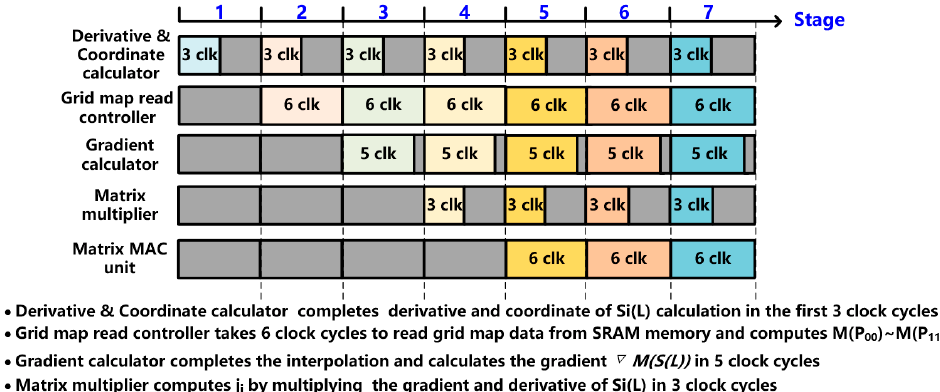
Figure 11. Pipeline diagram of the proposed NLO-CSM hardware accelerator.